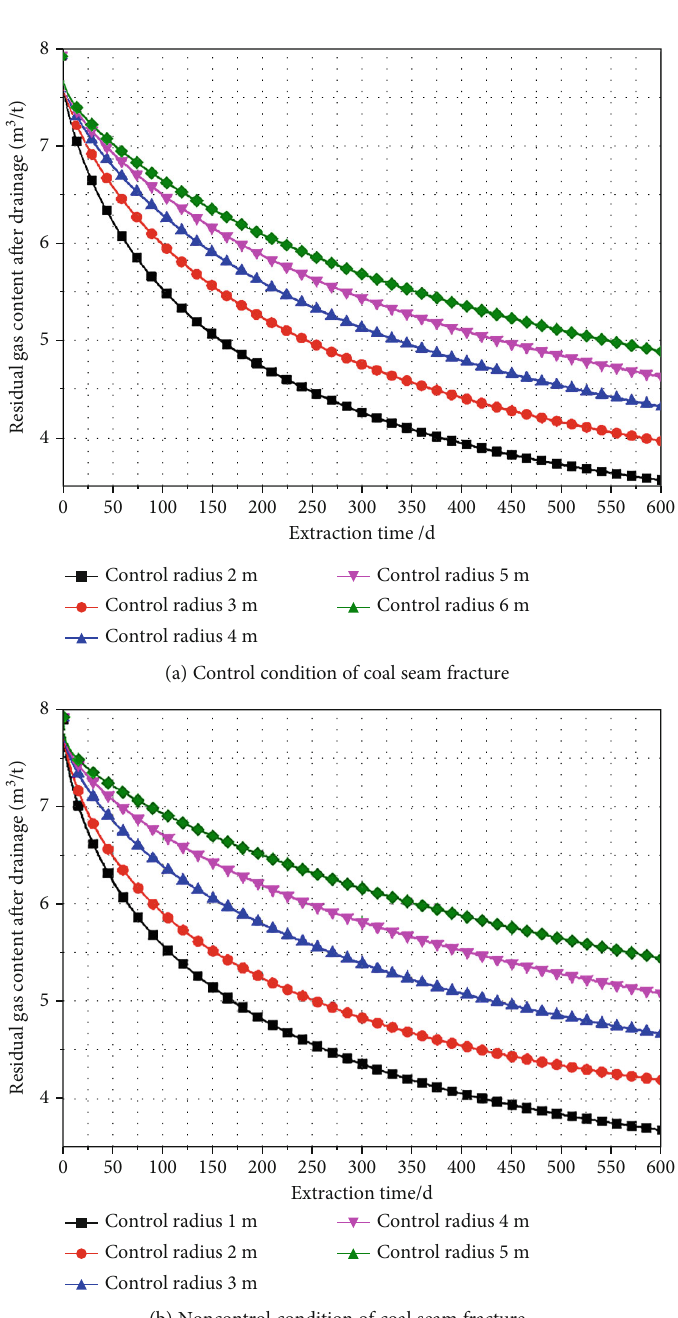
Figure 10: Residual gas content variation with time under di ff erent control radius and